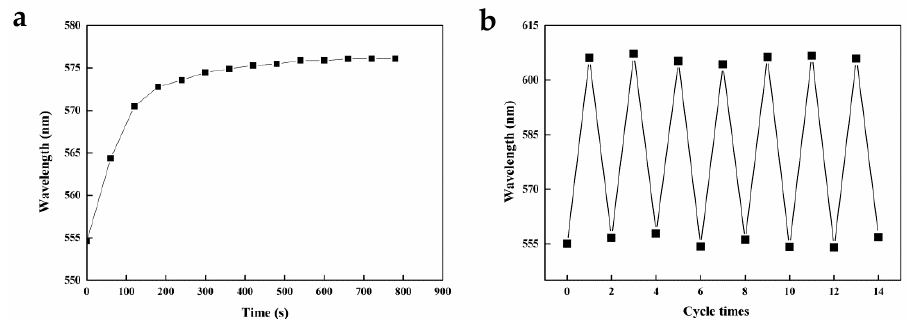
Figure 5. ( a ) Peak shift of the IOPPCs with time (10 mM PNP); ( b ) recoverability of the IOPPCs immersed in PNP solution (30 mM) and recovered by immersion in sodium bicarbonate solution (5%) followed by rinsing with deionized water.